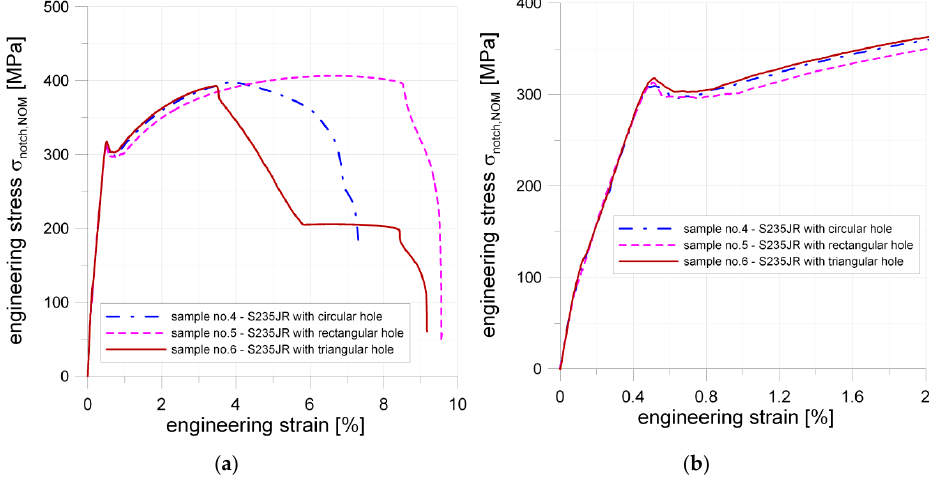
Figure 9. Tensile behavior of S235JR + N: ( a ) engineering σ – ε curves for tested specimens; and ( b ) engineering σ – ε curves for tested specimens–magnified initial part of the curve with elastic and plastic behavior of